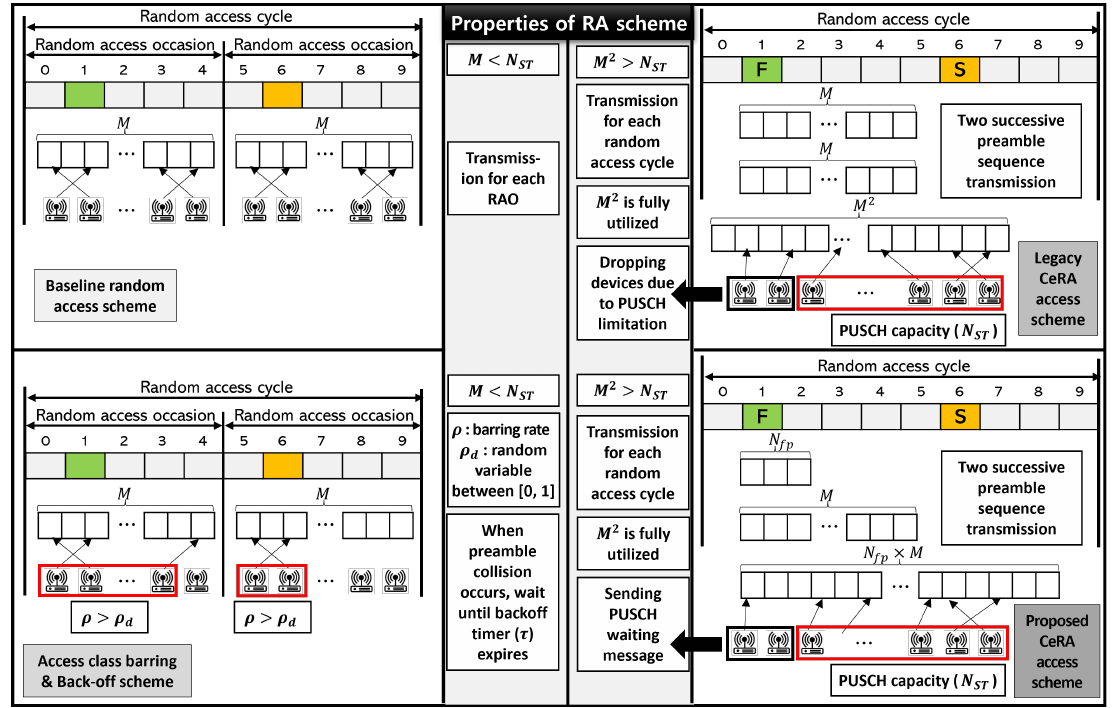
Figure 6. Comparison of different random access